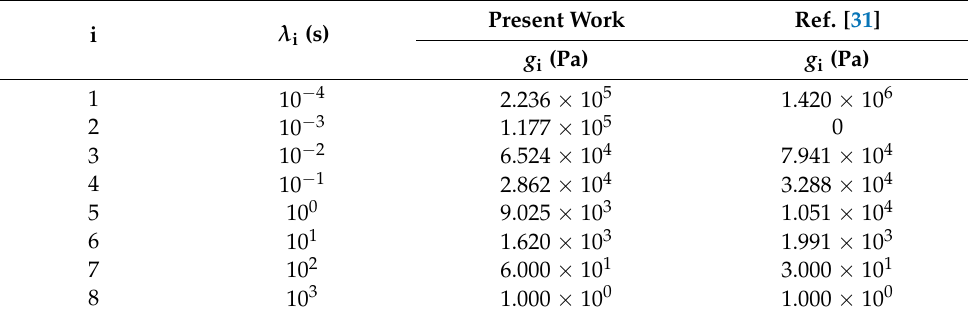
Figure 3. Shear viscosities of the LDPE (Q200) melt at 150 ◦ C and fitting by the RS model. Table 2. Relaxation spectra of the LDPE(Q200) melt at 150 ◦